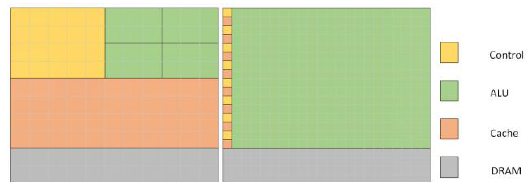
Figure 3. Comparison between CPU and GPU